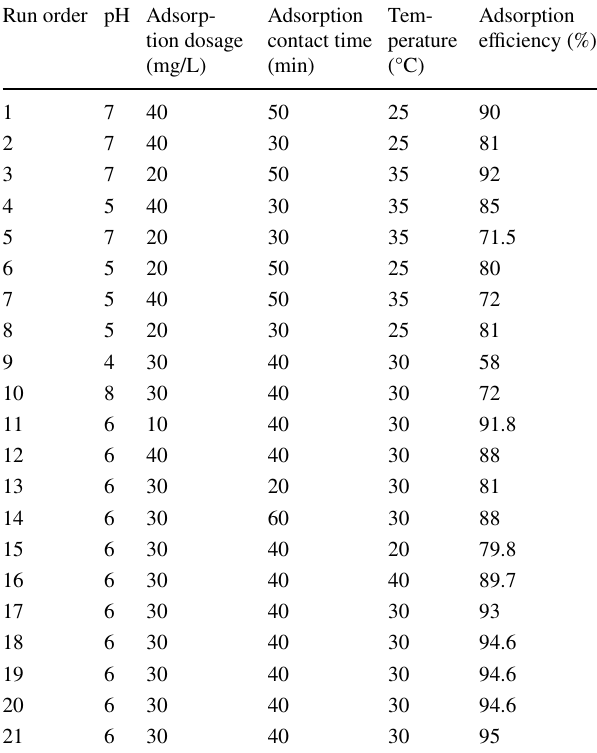
Table 5 Response (adsorption efficiency, %) data of adsorption of fibre cement industry effluent using coal-activated carbon based on experimental design matrix Run order pH Adsorp- tion dosage